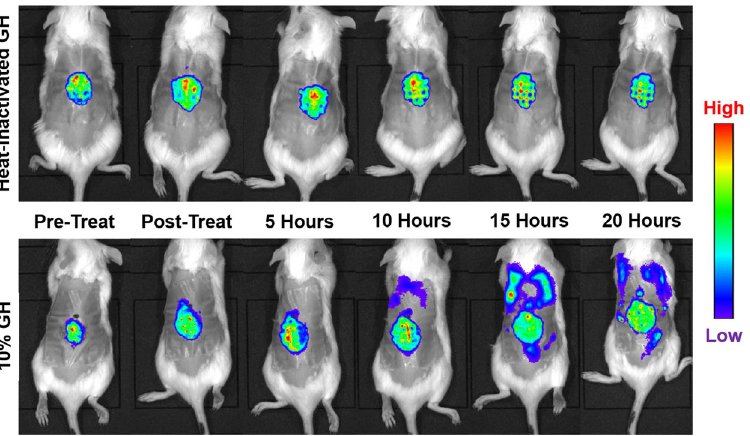
Figure 1. IVIS imaging of in vivo dispersal triggered by glycoside hydrolase therapy. Treatment of 48-hour-old mouse chronic wounds, infected with bioluminescent P. aeruginosa , with 10% α -amylase and cellulase (1:1; GH), or heat-inactivated control, resulted in dispersal and systemic spread of the infection. Clear localization of bacteria in the organs can be seen in the treated group. A representative animal from the treatment and control groups at each time point are